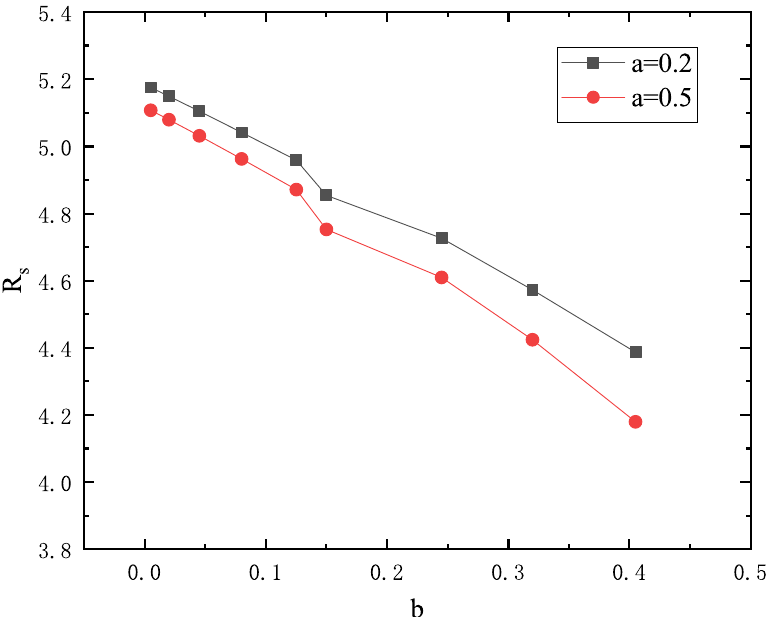
Figure 1. The shadow radius of KS black hole for different values of b when the rotating parameter chosen as a = 0.2 or a =